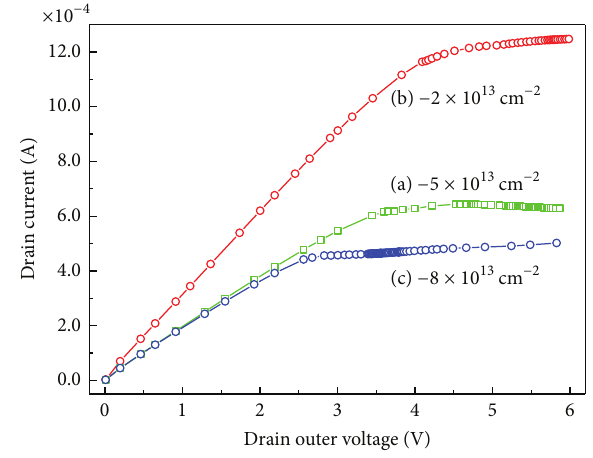
Figure 5: Drain current response versus drain voltage under different amount of surface